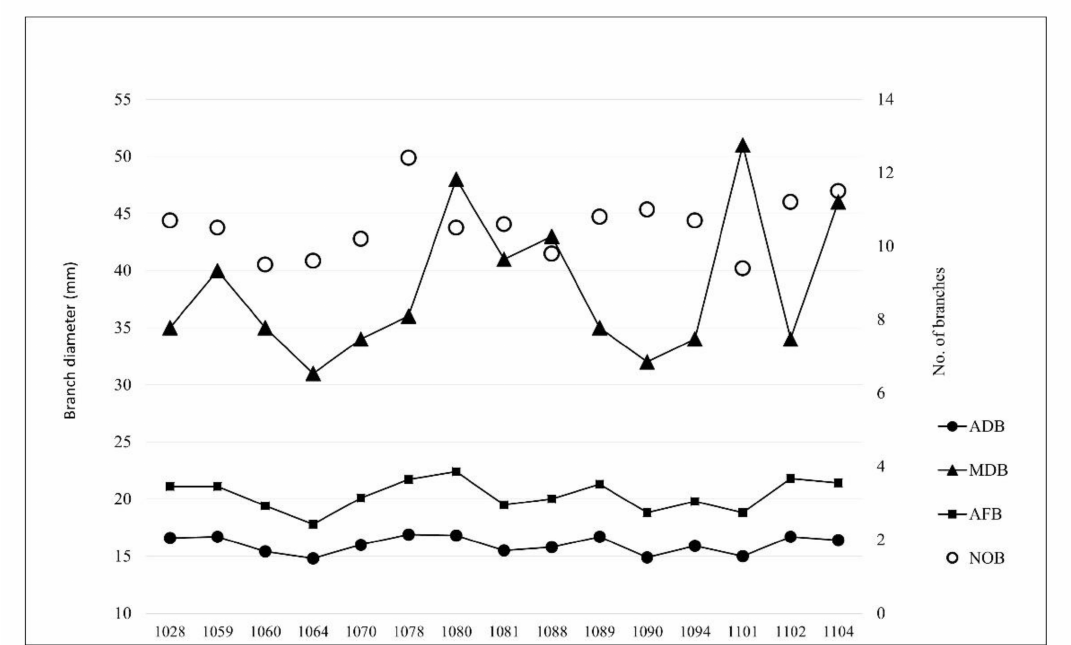
Figure 3. Combined graph of branch criteria, representing the mean values for the individual characteristics studied. See Table 1 for provenance